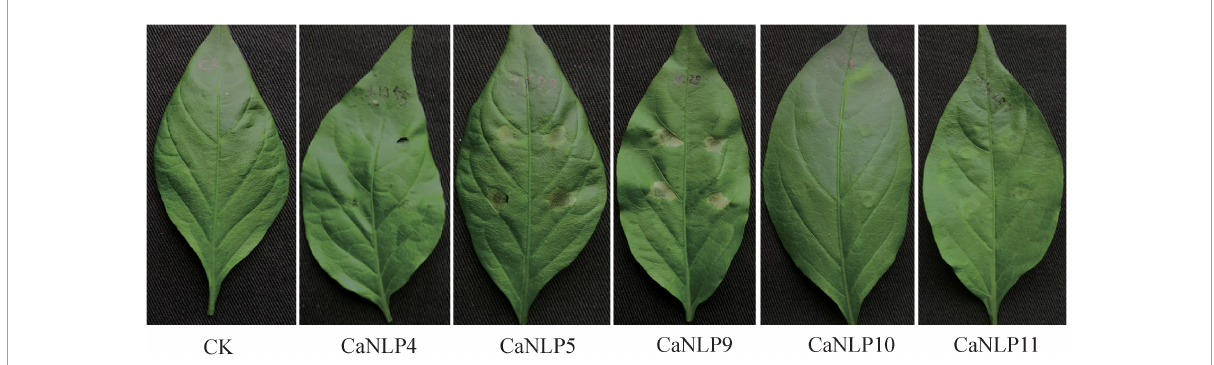
FIGURE3 Recombinant CaNLP proteins display cytotoxic activity on capsicum leaves. Pictures were taken at 3 dpi.